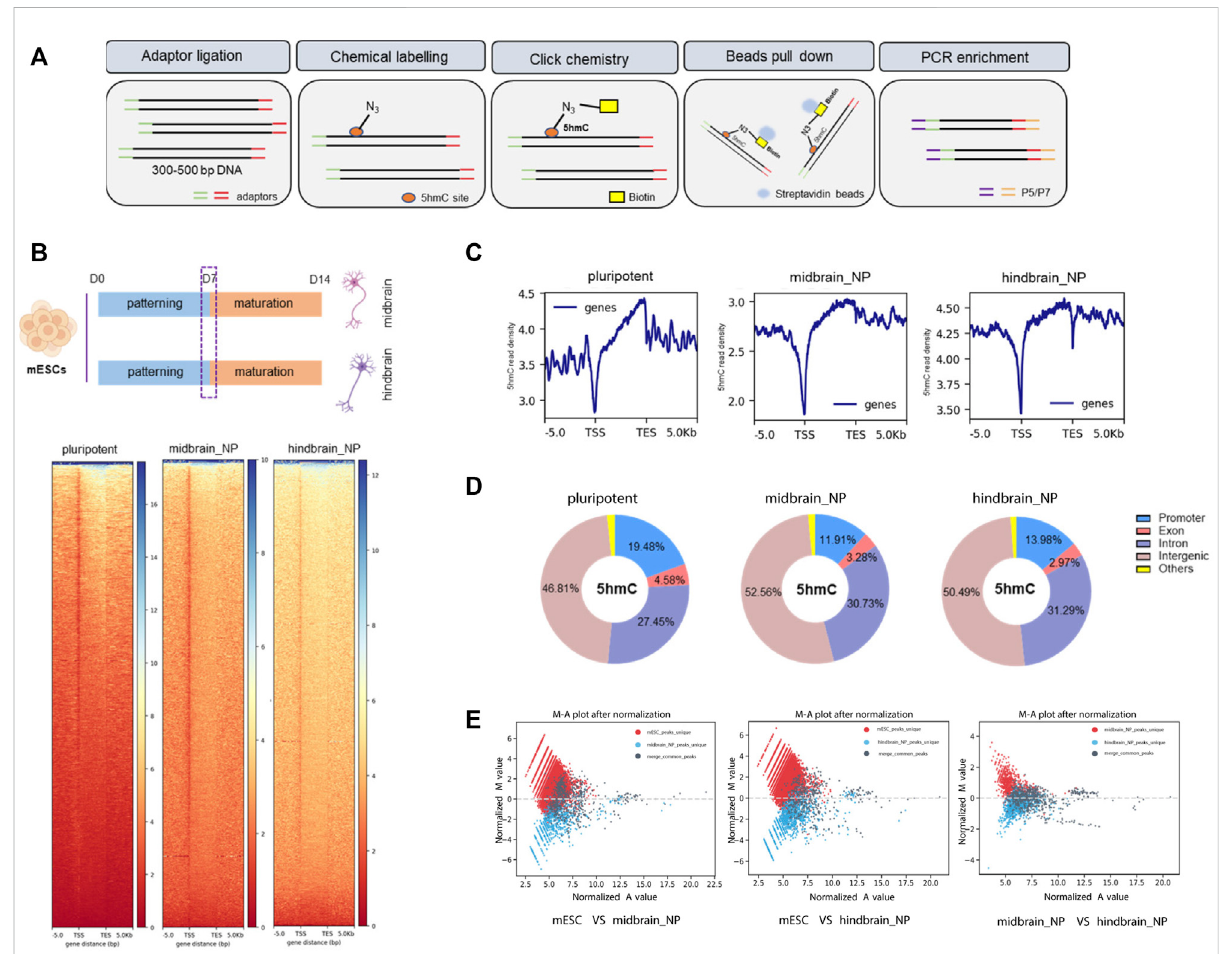
FIGURE 2 Characterizationofglobal5hmCdistributioninmidbrainandhindbrainprogenitorcells. (A) Schematicstepsfornano-5hmC-sealapproach. (B) Heatmap representation of 5hmC densities within 5 kb of transcription start site (TSS) and transcription end site (TES) in midbrain and hindbrain progenitor cells as a function of gene expression of level. (C) Metagene pro fi le for genes in pluripotent mESCs, midbrain, and hindbrain progenitors, from 5 kb upstream of the TSS to 5 kb downstream of the TES. (D) Genomic distribution of 5hmC-enriched regions in progenitor cells. Promoters were de fi ned as ± 5 kb from the annotated TSS. (E) MA plot of 5hmC peaks in midbrain/hindbrain progenitor cells and mouse ESCs after normalized by total reads using MAnorm normalization